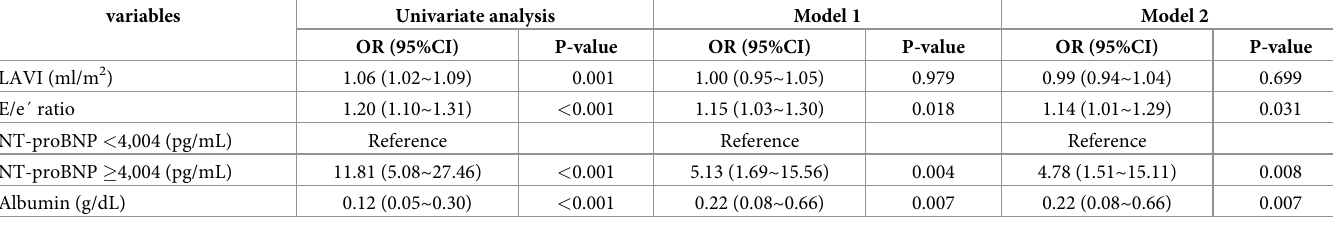
Table 4. Multivariate analysis using logistic regression: Predictive factors of being in the OH/ECW > 15%